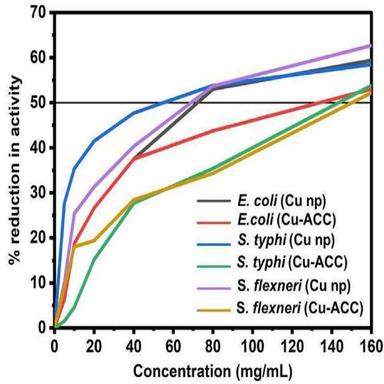
Percentage reduction in MTT activity (compared to negative control/viability of biofilms without treatment exposure) after 24 h exposure to treatments.